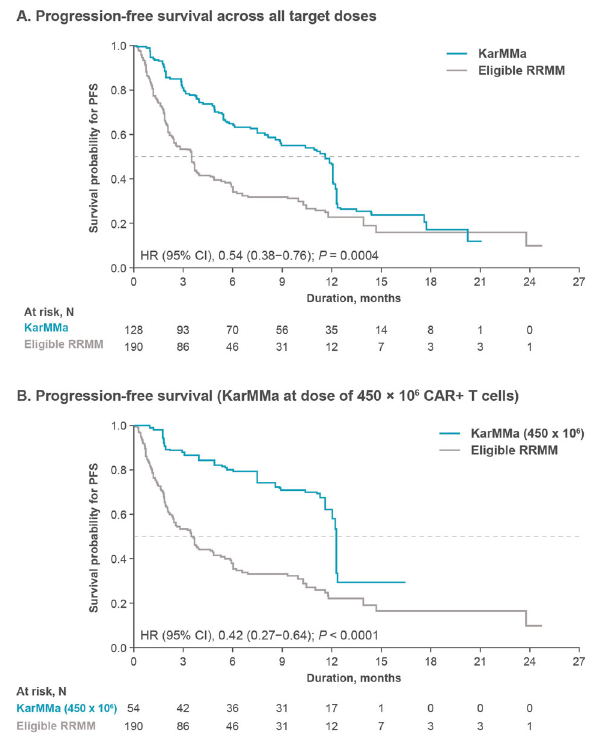
Fig. 2 Progression-free survival. A shows a Kaplan – Meier curve of progression-free survival across all target doses and B shows a Kaplan – Meier curve of progression-free survival at the target dose of 450 × 10 6 CAR + T cells based on Independent Response Committee Review according to IMWG criteria applying Food and Drug Administration censoring rules. IMWG denotes International Mye- loma Working Group, NE not